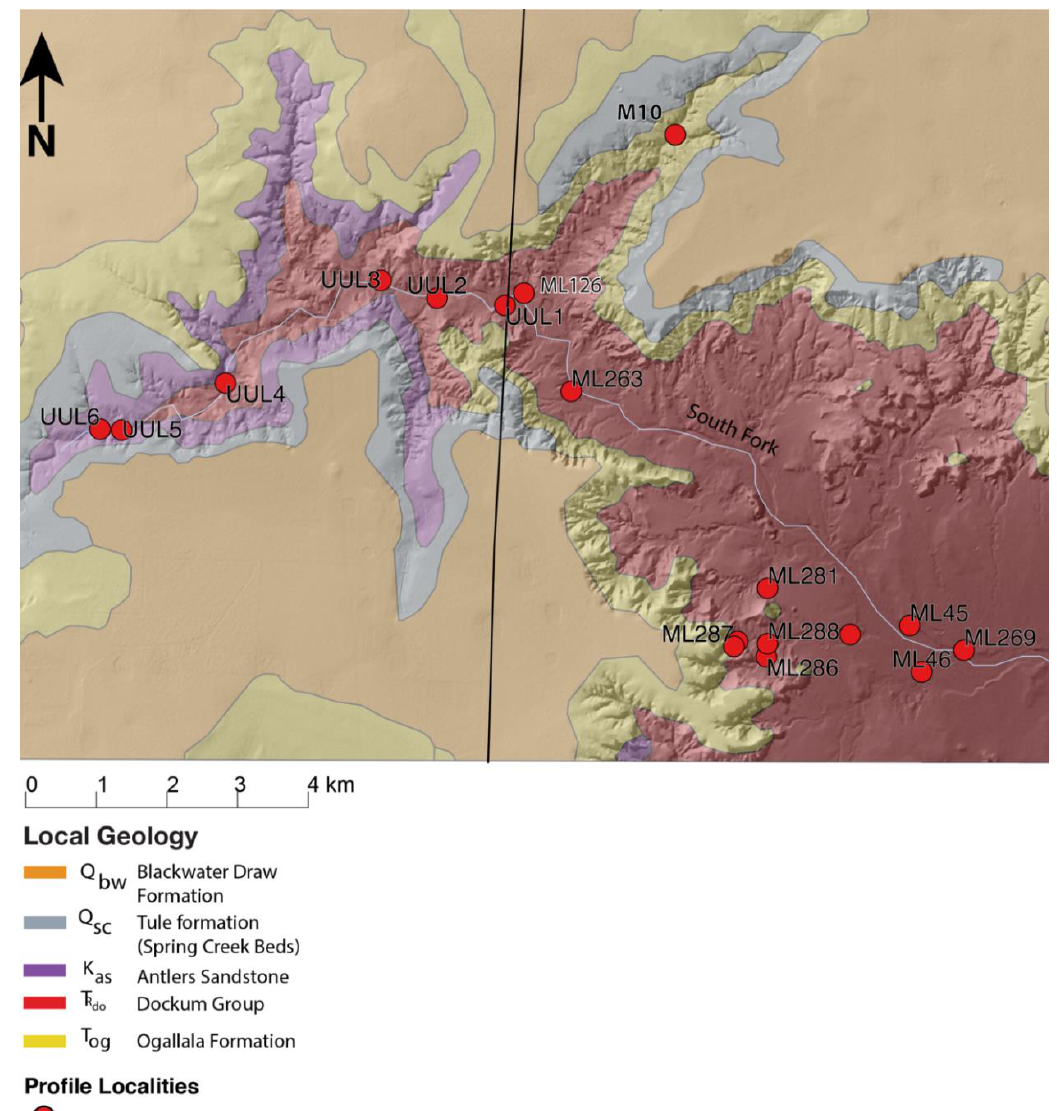
Figure 8. Geologic map with profile localities for the current study area in the eastern escarpment breaks of the Southern High Plains, Texas. Geologic source data derived from the Texas Geological Database (2014).